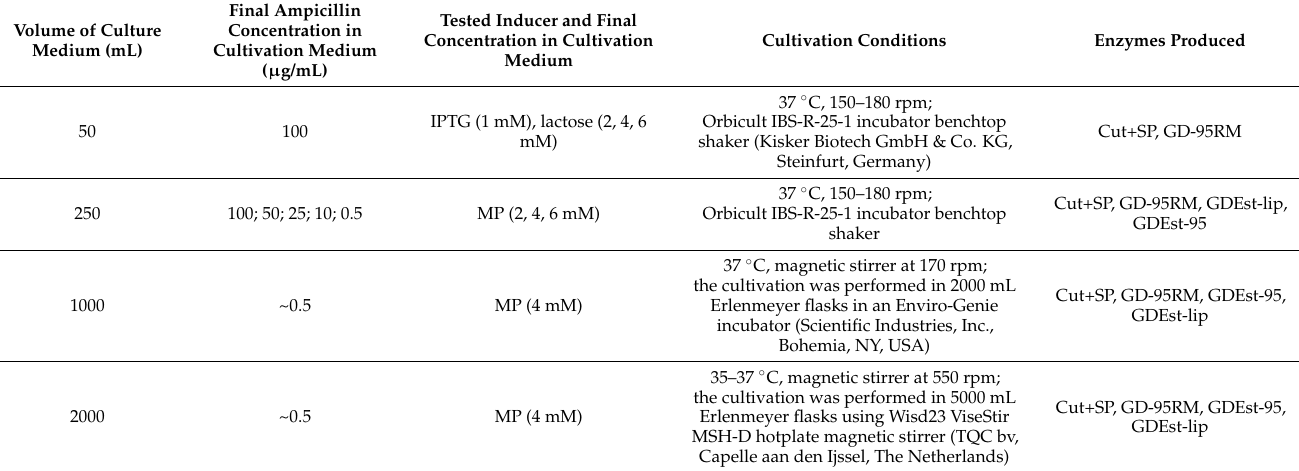
Table 1. Conditions used for recombinant E. coli BL21 (DE3) cell cultivation and Cut+SP, GD-95RM, GDEst-95, and GDEst-lip recombinant enzyme production. IPTG—isopropyl- β -D-thiogalactoside; MP—milk